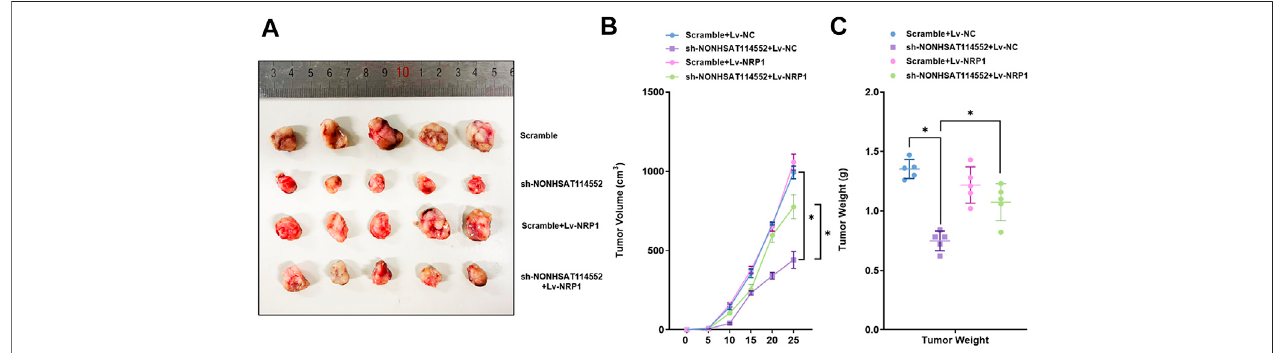
FIGURE 7 | Effects of NONHSAT114552/miR-320d/NRP1 axis on tumorigenesis of chordoma in vivo (A) . Appearance of tumors formed in shNONHSAT114552, shNONHSAT114552+Lv-NRP1, Lv-NRP1 or control group respectively (B) . Tumor volume was assessed from each group at different point of time (C) . Tumor weight was evaluated in every